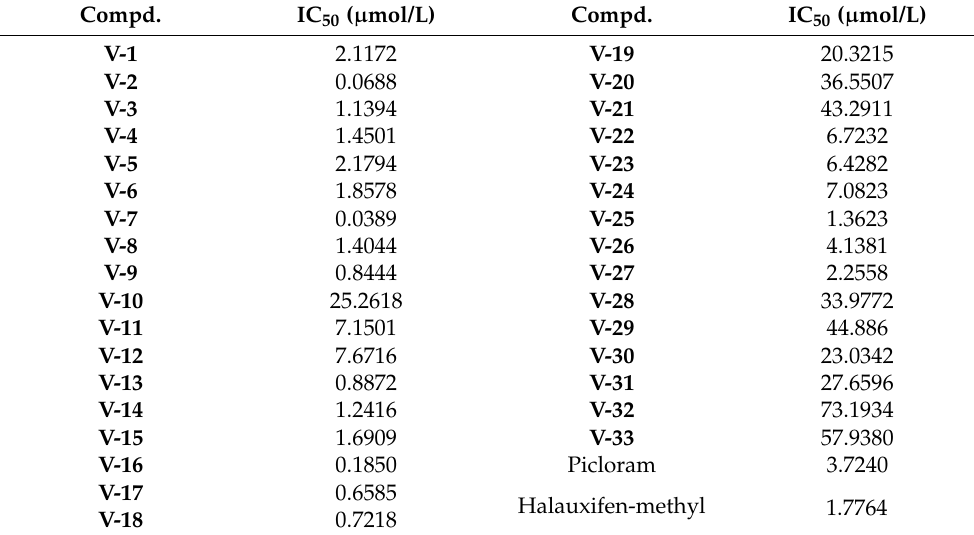
Table 2. IC 50 values of all compounds against A. thaliana root growth inhibition. Compd. IC 50 ( µ mol/L) Compd.